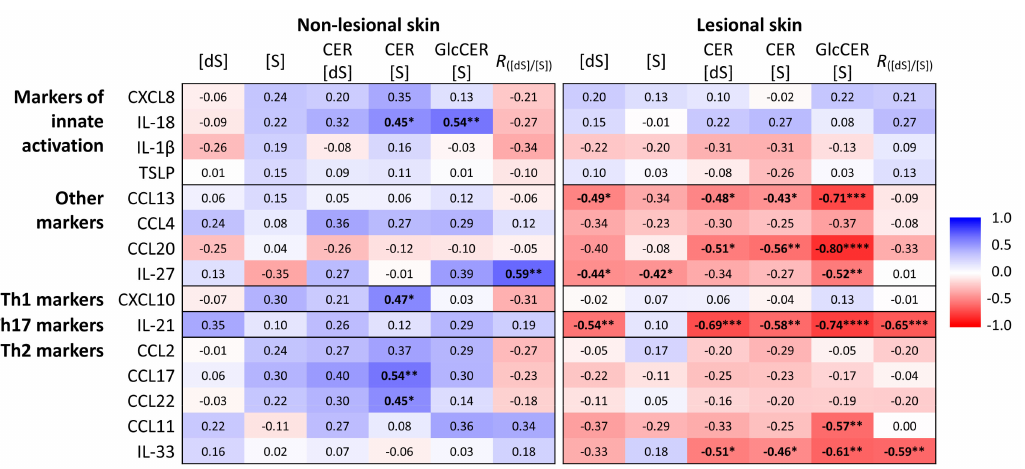
Figure 7. Spearman’s correlation coe ffi cients between ceramide markers and cytokines. (S) = sphingosine, (dS) = sphinganine, CER (S) = sphingosine-related ceramides, CER (dS) = sphinganine-related ceramides, GlcCER (S) = glucosylceramide. **** p < 0.0001, *** p < 0.001, ** p < 0.01, * p <